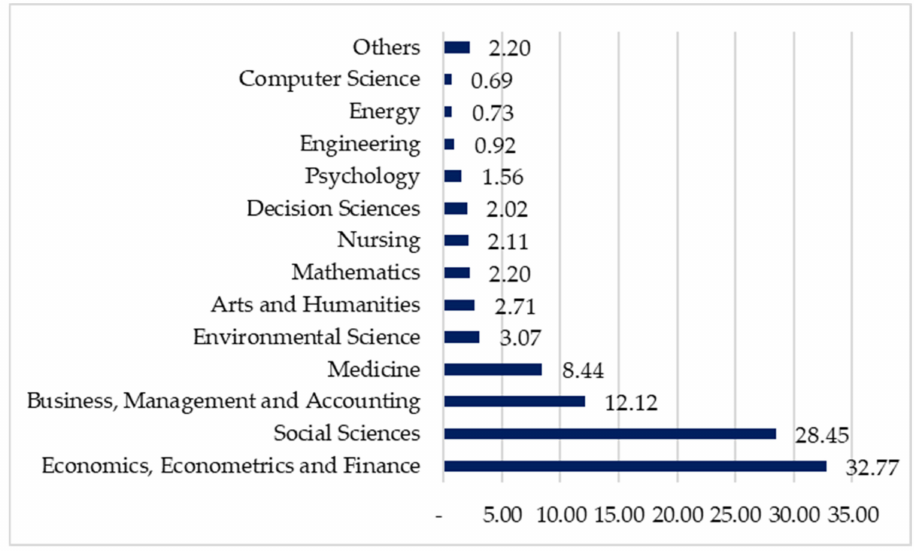
Figure 3. Documents by subject area (percentage) on pension research. Source: own